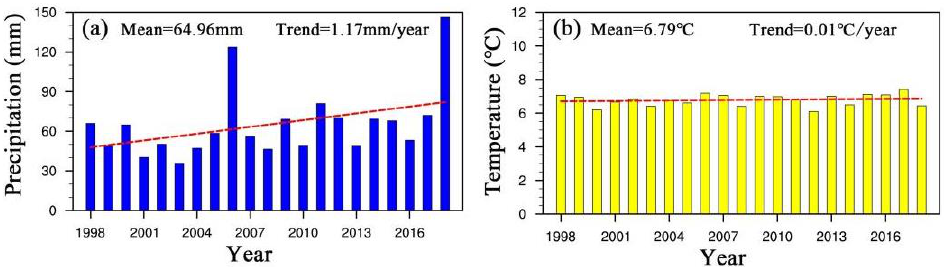
Figure 2. Average annual precipitation ( a ) and temperature ( b ) of the study area in 1998–2018.